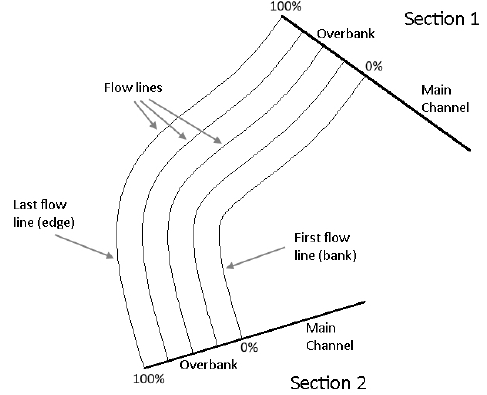
Figure 32. The anticipated flow lines between the floodplains.